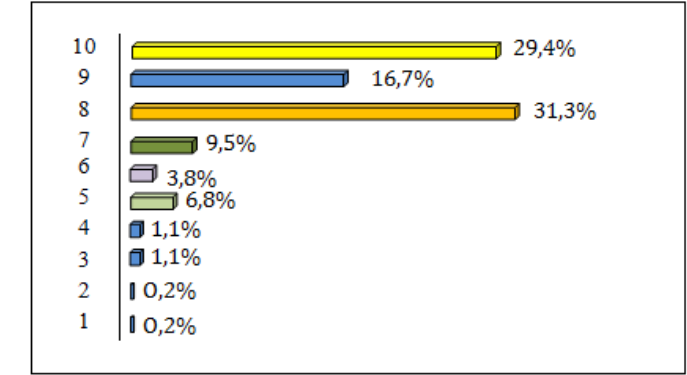
Figura 12. Percentual com avaliação de nota de 1 a